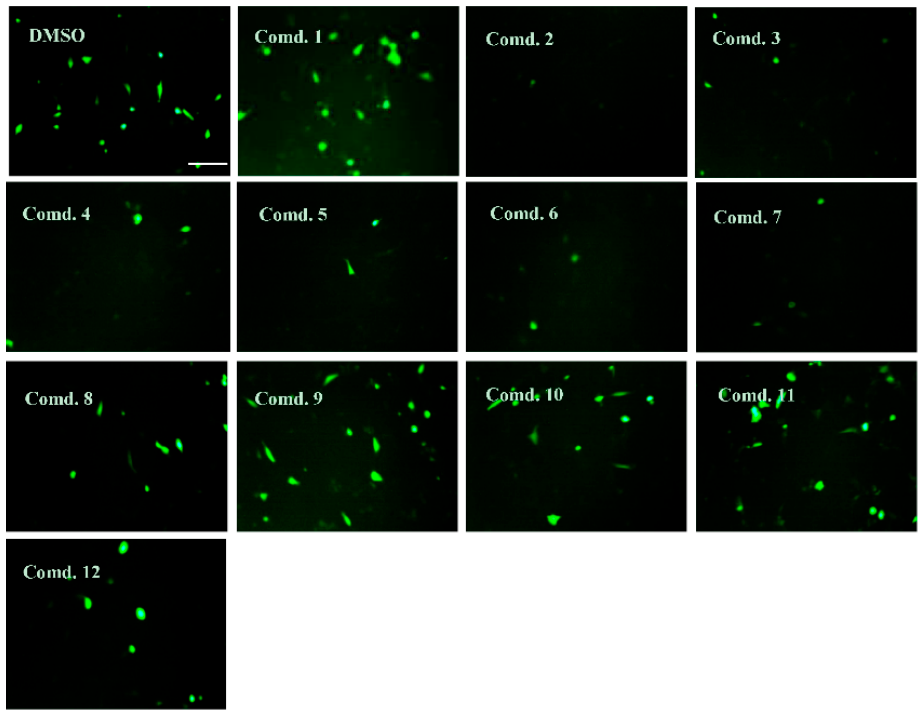
Figure 5. Effects of compounds 1 – 12 on the intensity of the green fluorescence induced by pEGFP- C1/A β 42 plasmid transfection using Lipofectamine in HT22 cells after 10 h of transfection. The transfected cells were continually exposed to the test compounds at 20 μ M. After incubation for 24 h, the cells were visualized using fluorescence microscopy.